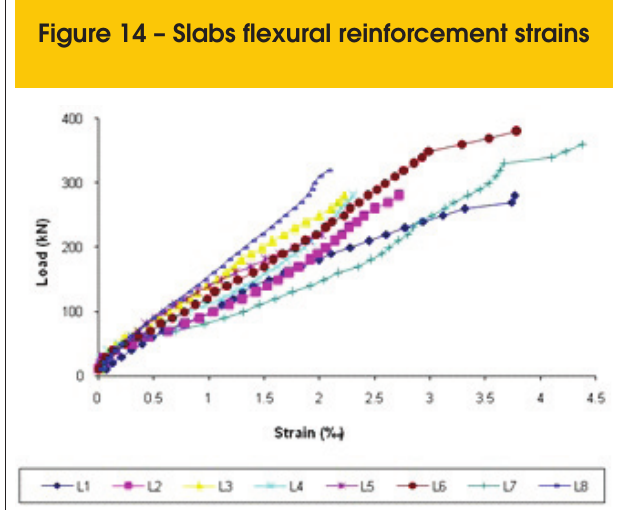
Figure 14 – Slabs flexural reinforcement